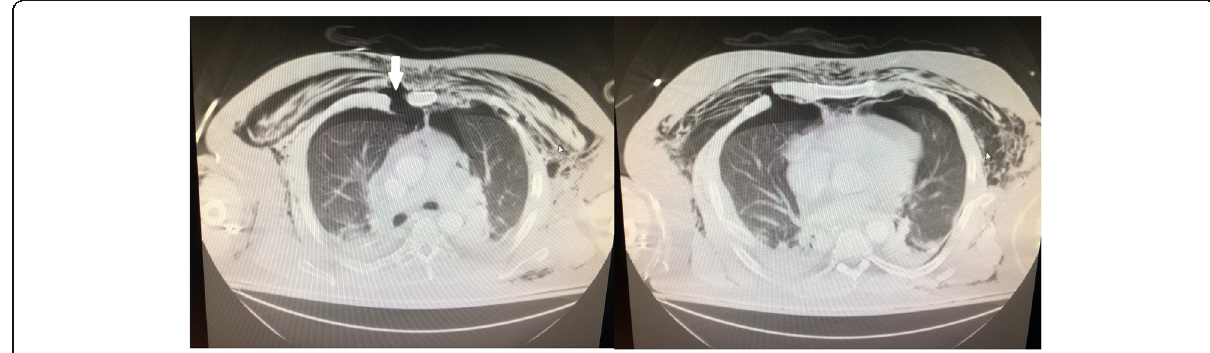
Fig. 1 Initial chest CT (Lung Windows) axial cuts, showing extensive subcutaneous emphysema, with associated bilateral pneumothoraces, small residual bilateral hemothoraces and associated pulmonary contusions. The right panel shows a displaced 3rd rib sternochondral dislocation (solid white arrow), providing a clear path for a possible pulmonary hernia. The left panel shows displaced rib fractures just inferior to the right sternochondral dislocation, creating an anterior flail